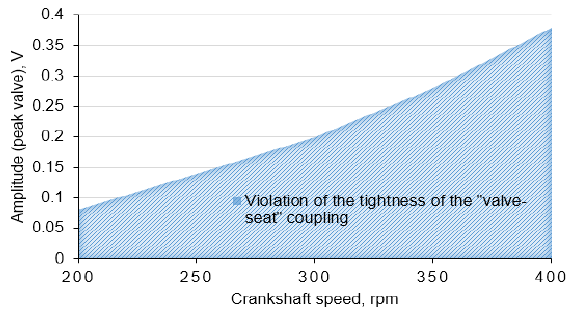
Figure 12. Limitations (fixed geometry)